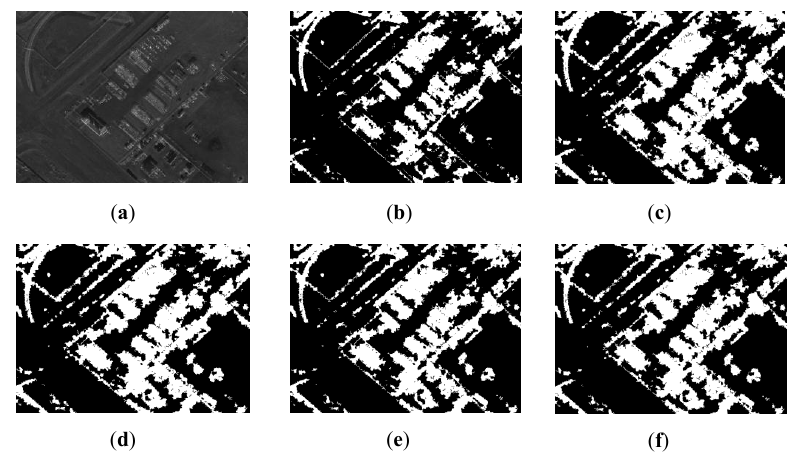
Figure 14. Segmentation results on SAR5. ( a ) original image; ( b ) AFWDLMO; ( c ) AFCMOMA;